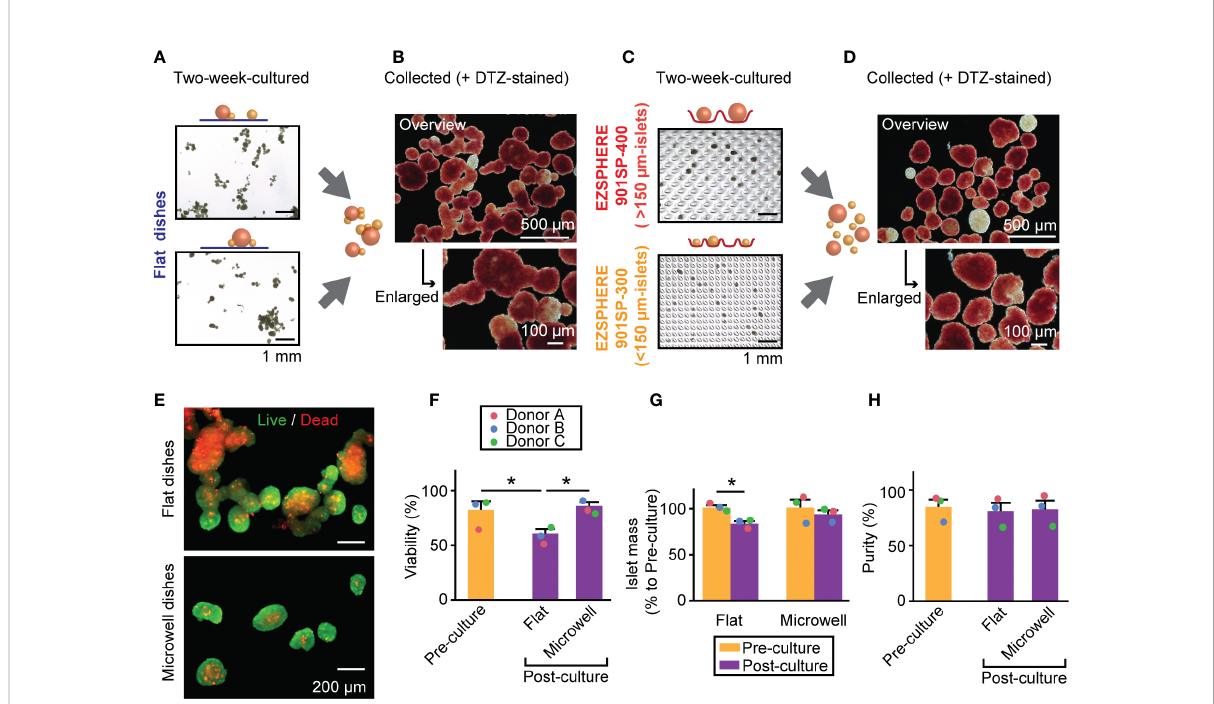
FIGURE 4 Islet morphology, viability and mass in a two week-culture of human islets. (A) A bright- fi eld image of two week-cultured islets on the conventional fl at-bottomed dishes. Scale bar: 1 mm. (B) Combined islets from two fl at dishes and stained with DTZ. Overview (upper, scale bar: 500 µm) and enlarged picture (bottom, scale bar: 100 µm). (C) A bright- fi eld image of two week-cultured islets in microwell dishes. Upper picture: >150 µm-islets in EZSPHERE 901SP-400. Bottom picture: 50 – 150 µm-islets in EZSPHERE 901SP-300. Scale bar: 1 mm. (D) Combined islets from two microwell dishes, stained with DTZ. Overview (upper, scale bar: 500 µm) and enlarged picture (bottom, scale bar: 100 µm). (E) Live/dead staining of two week-cultured islets from fl at dishes (upper) and microwell dishes (bottom). (F) Viability assessment of islets from three donors. Data of each donor is plotted as different color dots (red, blue and green for Donors A, B and C, respectively). Pre-culture data is presented in yellow bar and post-culture in purple. * P < 0.05 in Student ’ s t-tests. (G) Islet mass analysis shown as % relative value to that of pre- culture. n = 3 donors. * P < 0.05 in Student ’ s t-tests. (H) Islet purity analyzed by DTZ staining. n = 3